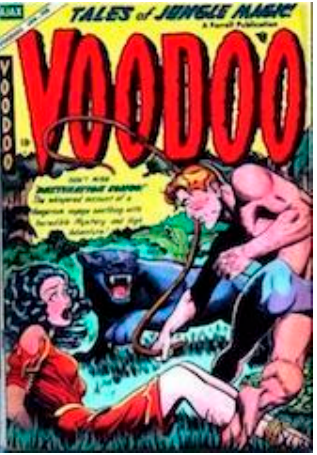
Figure 8. White jungle king tropes. Voodoo Comics , 1955.